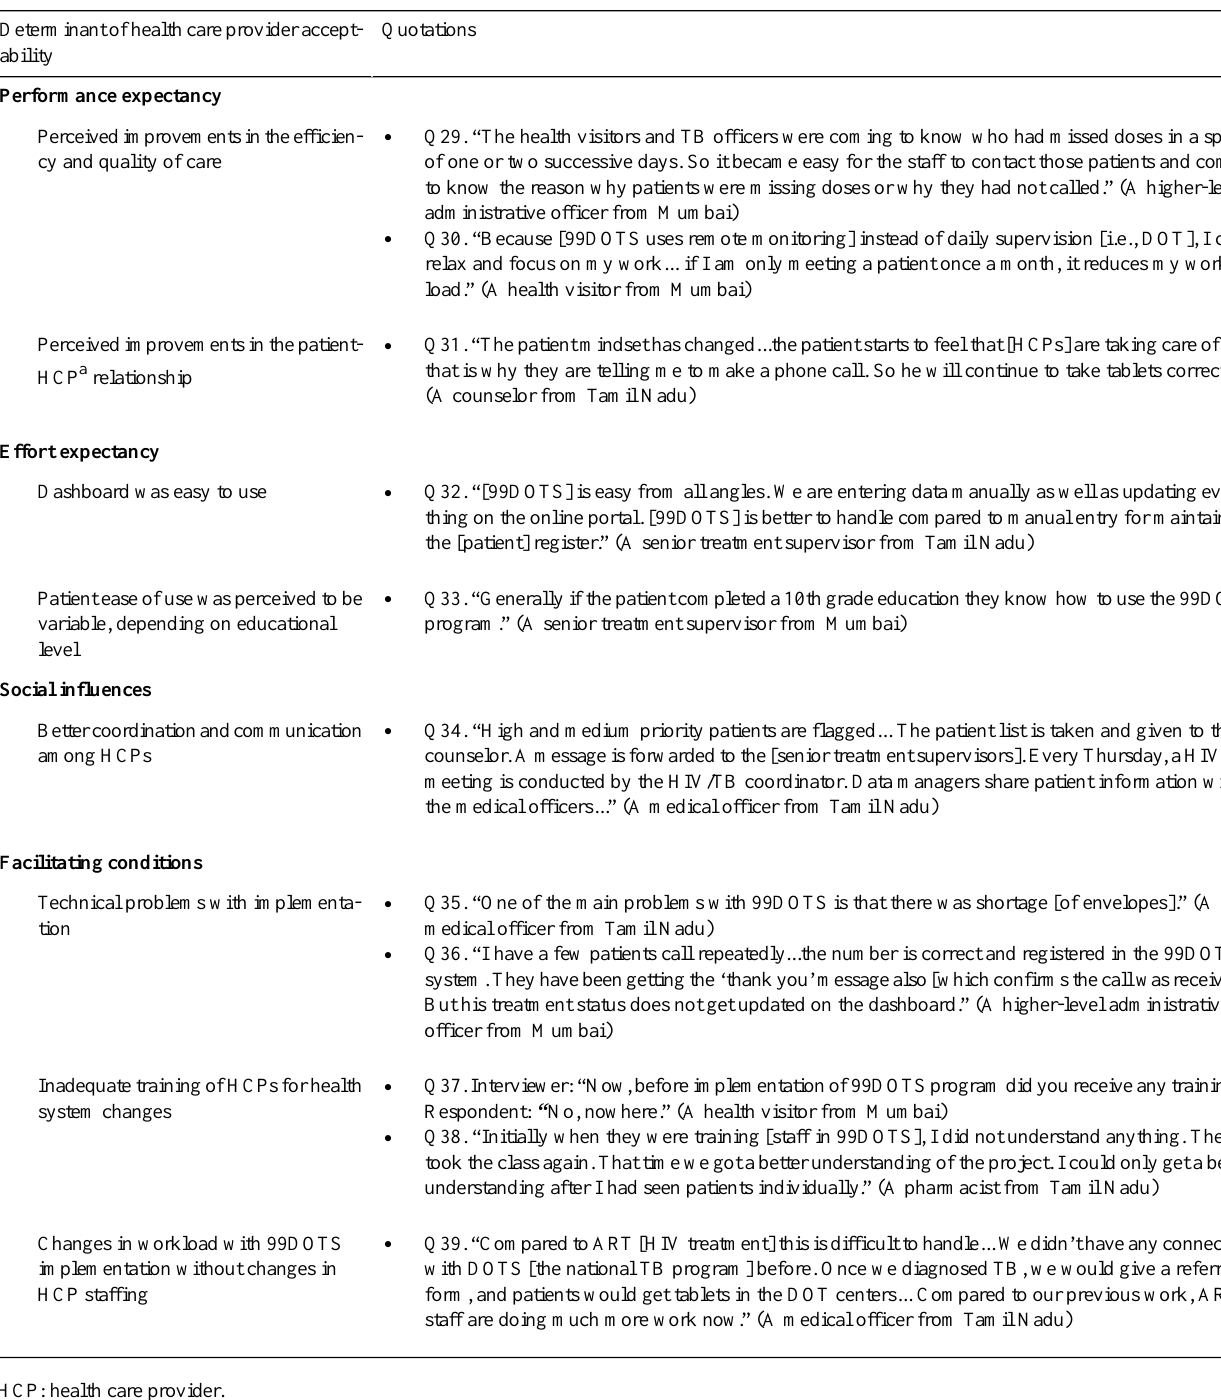
Table 3. Representative quotations on determinants of health care provider acceptability and use of 99DOTS. QuotationsDeterminant of health care provider